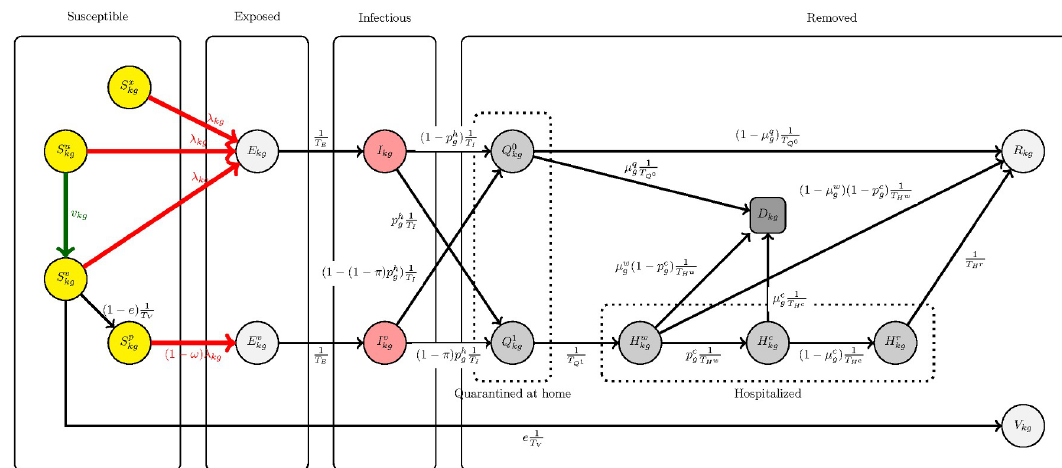
Fig 1. Disease transmission dynamics. Each node in the diagram corresponds to one differential equation with the time derivative of the associated variable on the left side, the values of the source nodes of incident arrows on the right side, each incoming arrow equipped with a plus sign, and each outgoing arrow equipped with a minus